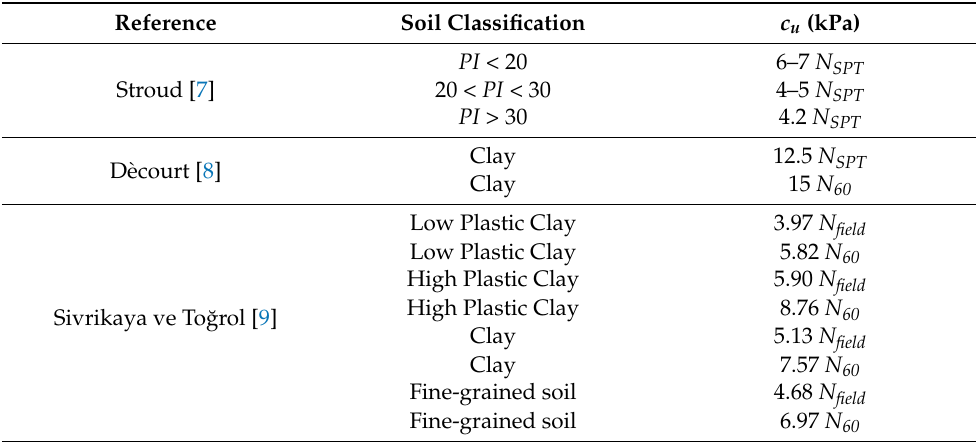
Table 2. Correlations between N SPT and c u based on soil